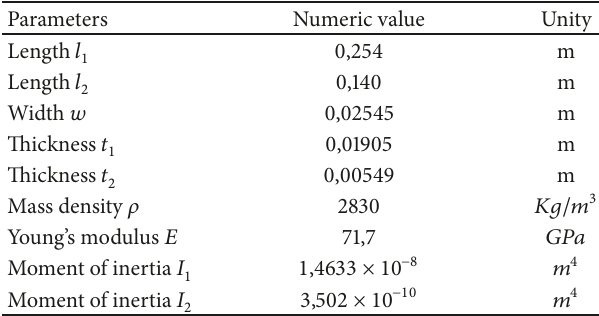
Table 4: Parameters of the double-span beam